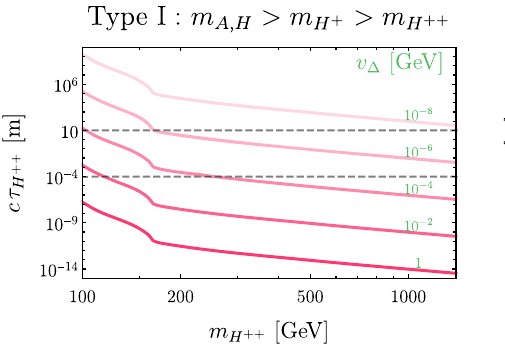
Fig. 7 Lifetime (times the speed of light) of the lightest exotic Higgs state for type I (left) and type II (right) as a function of mass and v (cid:4) (setting λ 2 = λ 3 = λ 4 = 0). The remaining parameters are chosen such that CDF-II m W value is explained. The sharp drop at around 160 GeV correspond to the threshold at which the WW decay becomes on shell. For type II (right), additional sharp drops occur at around 250 (215) GeV where H → hh ( A → Zh ) becomes on shell; furthermore,